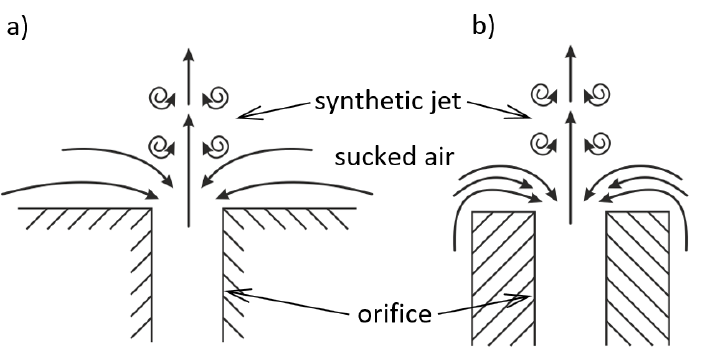
Figure 6. The supposed way of air ingestion for the synthetic jet with ( a ) and without ( b ) confinement plate.